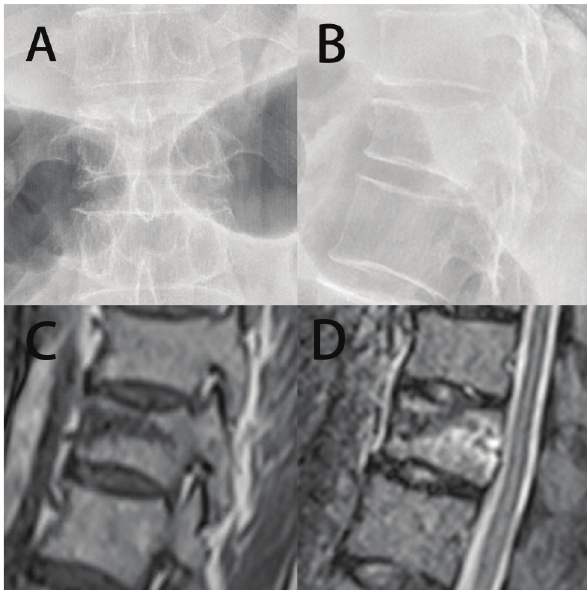
Figure 3 - Typical X-ray and magnetic resonance (MR) images of OVCFs. A and B, Posterior-anterior and lateral X-ray films showing a compression fracture in T12. Both endplates were fractured. C and D, MR images showing marrow edema in the fractured vertebral